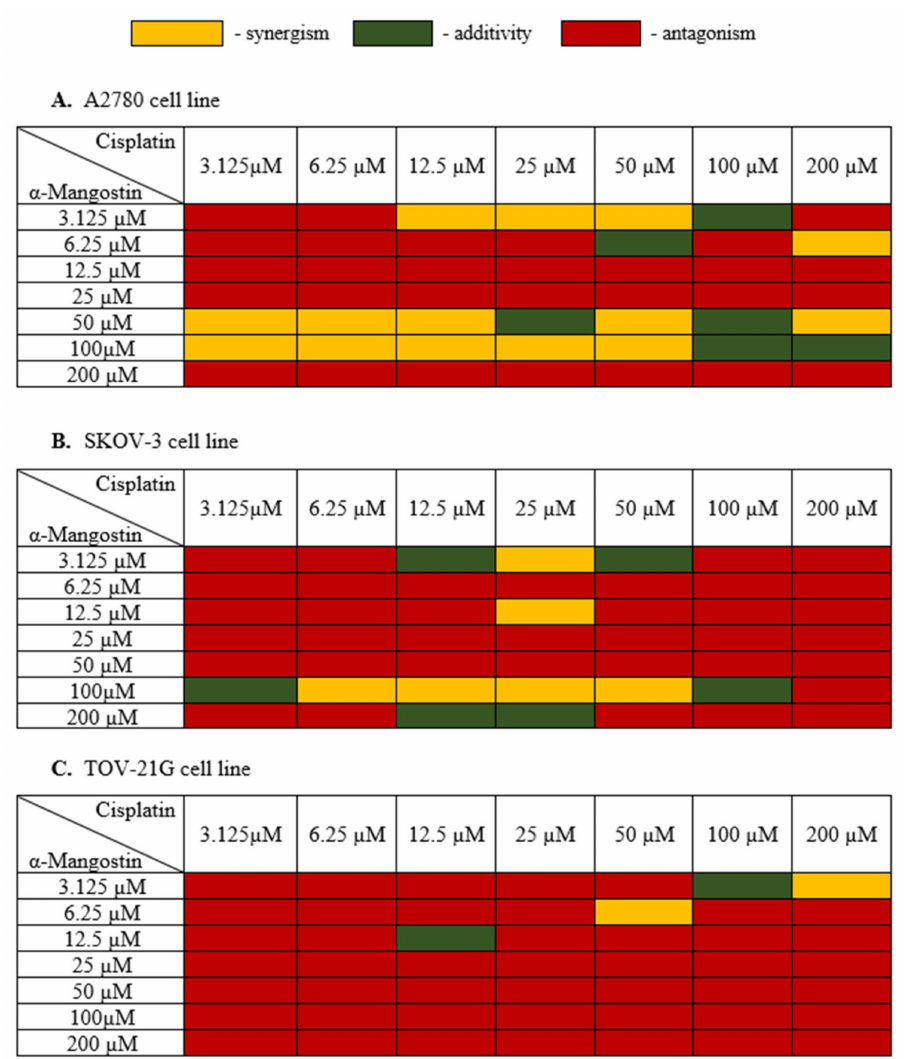
Figure 3. Cytotoxic effect α -mangostin—cisplatin combination in ( A – C ). After the XTT test was performed, the CI value was determined with CompuSyn (ComboSyn, Inc., Cambridge, MA, USA) and a heat map was generated. Yellow indicated a synergistic effect when the CI value was less than 0.9; green color when the effect of drugs was additive when the CI value was from 0.85 to 1.1; red color indicated an antagonistic effect when the CI value was above